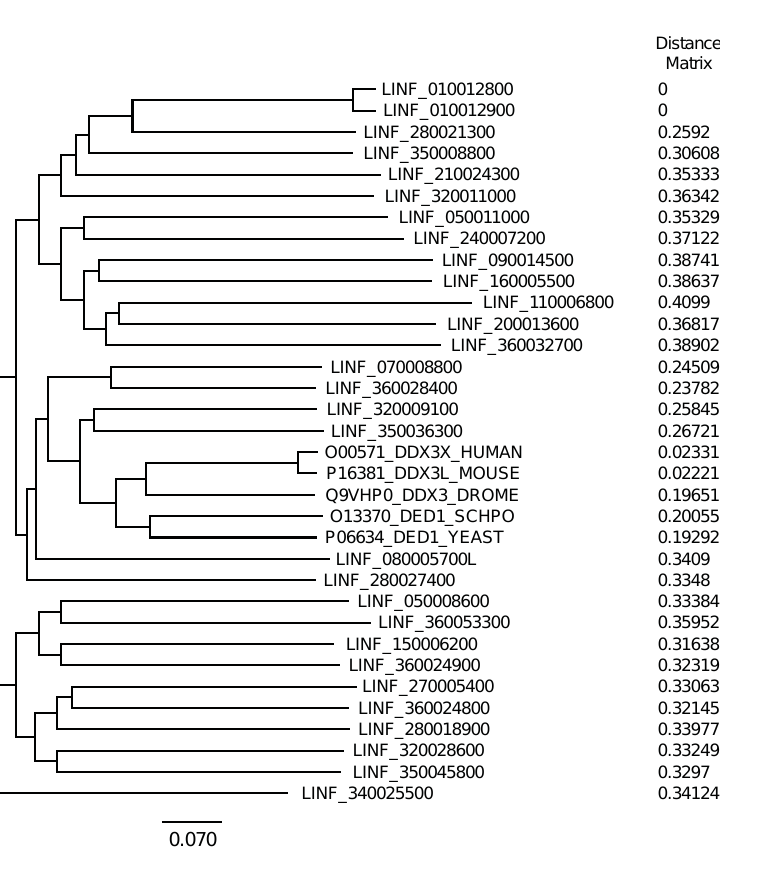
Figure 1. Phylogenetic tree of LINF and Ded1/DDX3 proteins. A neighbor-joining tree is shown with the branch lengths and distances as shown. The UniProt identifying numbers are shown for the Ded1 and DDX3 proteins, and the TriTryp numbers for L. infantum . The DDX3 proteins were from humans, mice and Drosophila melanogaster , and the Ded1 proteins from Schizosaccharomyces pombe and S. cerevisiae .